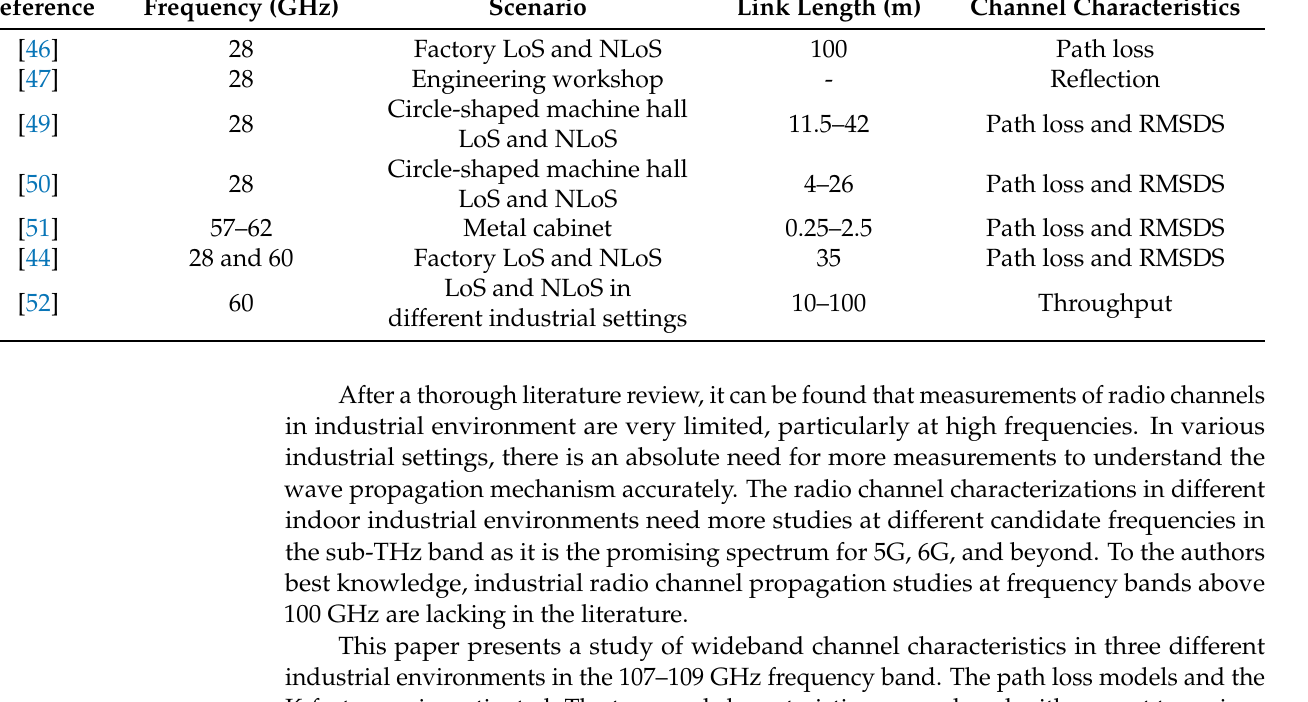
Table 2. Channel characterization studies in indoor industrial environments in the mmWave band.